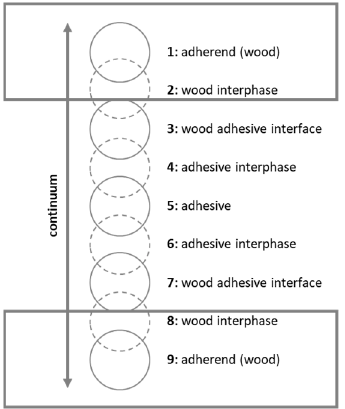
Figure 1. Own representation based on [21] and [22]. Marra [21] described the bonding as a nine-zone model. Frihart [22] stated that a continuum exists from adherend (1) through adhesive (5) to adherend (9), rather than discrete zones.